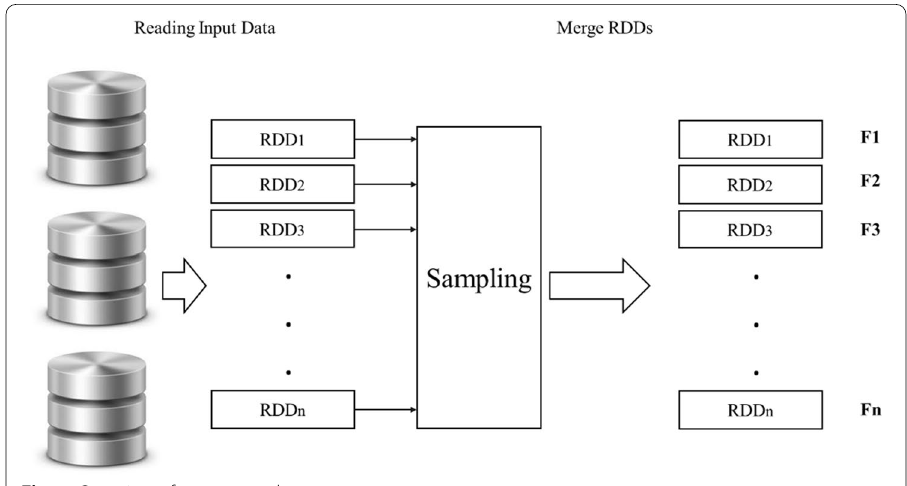
Fig. 4 Overview of our